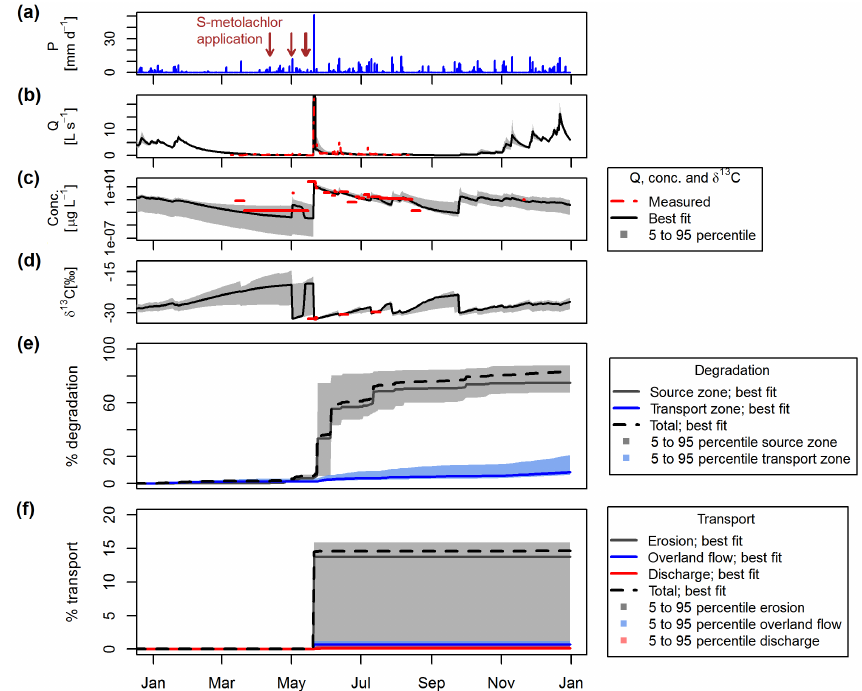
Figure 5. Daily precipitation ( P ; a ), measured (red lines) and modelled time series for discharge ( Q ; b ), S-metolachlor concentrations ( c ; note the log-scaling), and δ 13 C values (d) at the catchment outlet in 2012, as well as model mass balance for degradation (e) and transport processes (f) within the catchment. The black line indicates the results of the calibration run with the best fit in terms of N Q / 6, N C , and N δ 13 C . Shaded areas show the range between the 5th and 95th percentiles of all simulation results. Brown arrows in (a) indicate the dates of pesticide application. Table 4. Model mass balance for degraded and transported pesticide in 2011, 2012, and the study period (12 April to 17 July). Numbers are relative to the annually applied pesticide mass. The bold values give the sum of the individual mass balance terms for pesticide degradation, retention and transport,